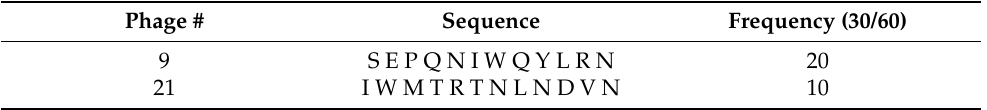
Table 2. Analyzed peptide